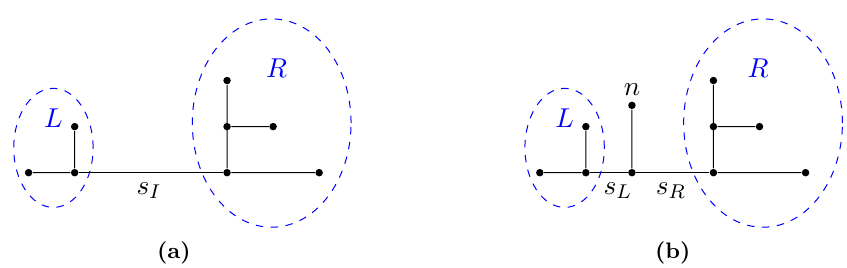
Figure 6. The inverse-soft construction for cubic tree diagrams and proof of claim